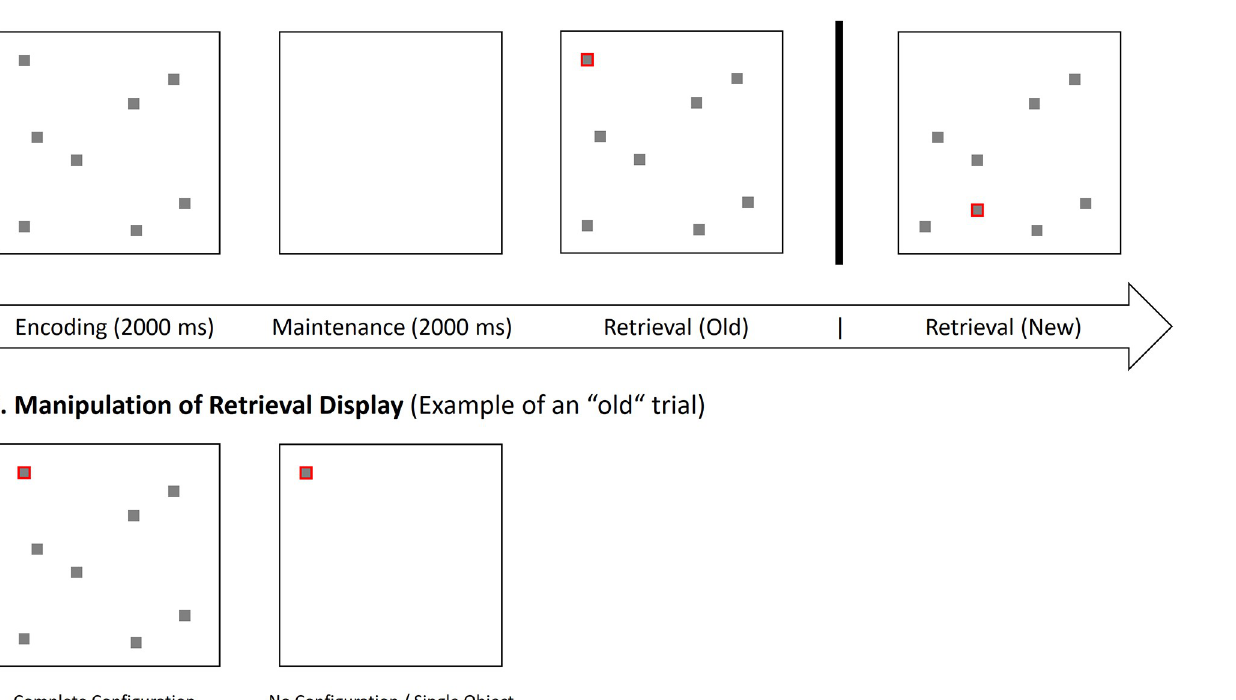
Fig 1. Location change detection task. Note that the fixation cross is not displayed in this figure for illustrative purposes.